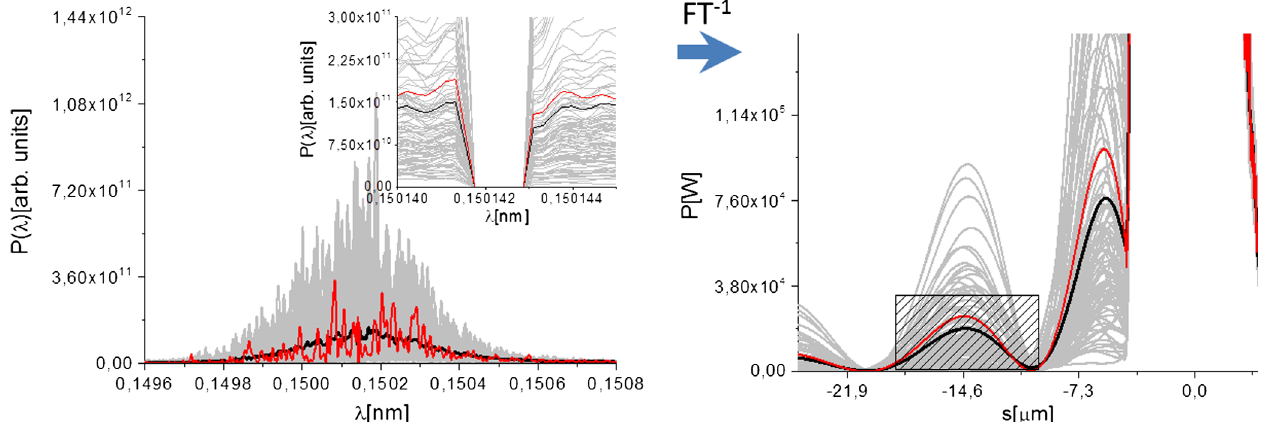
FIG. 2. Schematics of the single-crystal HXRSS principle. After filtering, in the time domain, the FEL is characterized by a tail of monochromatic radiation. This can be used as seed by tuning the chicane delay such that the electron bunch is superimposed on it. In the right plot, this position is indicated by a black rectangle. Grey, black and red lines follow the same convention as in Fig.